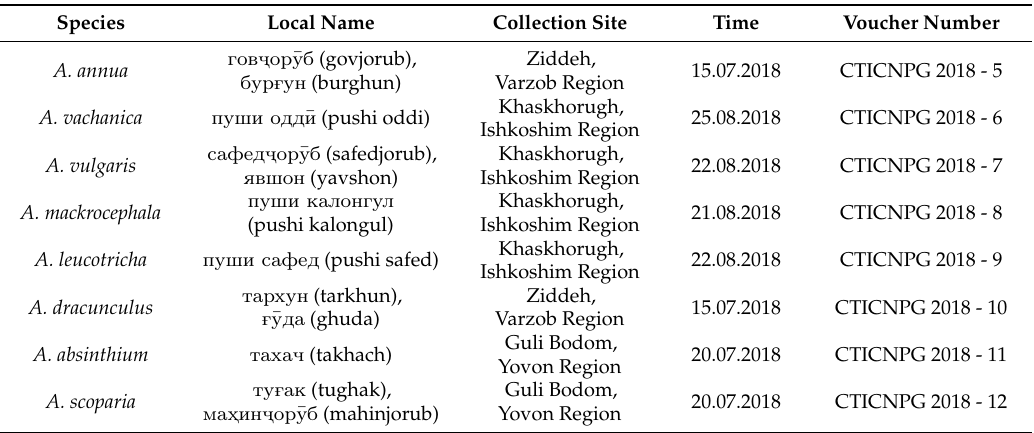
Table 1. Artemisia species collected from